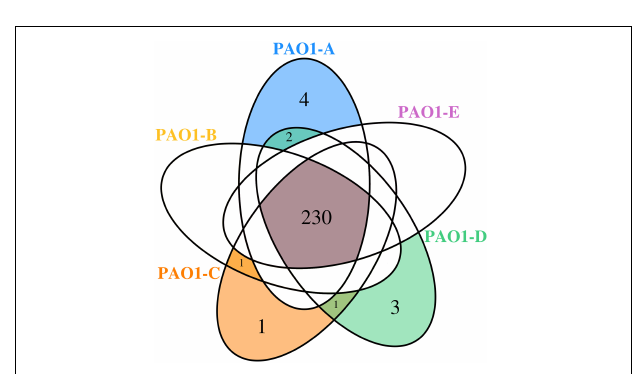
in the PA0717-PA0727 genomic region and the deletion in PA4684/PA4685 region were also detected in P. aeruginosa PAO1-DSM (Davies and Davies, 2010), and P. aeruginosa isolates PA14 (Klockgether et al., 2011). One unique SV detected in PAO1-C sublines was due to 8,384 bp deletion in the region containing genes of the mexT ,